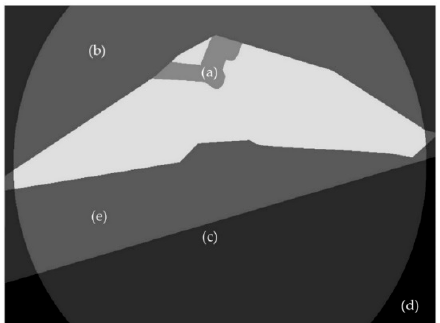
Figure 7. Mask layers: ( a ) spark plug and shadow; ( b ) cylinder head and valves; ( c ) light sheet limit;